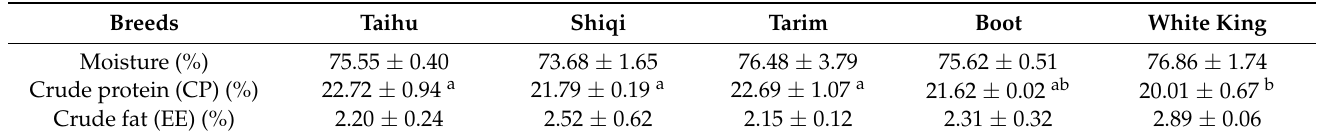
Table 2. Comparison of conventional nutritional compositions between different breeds of pigeons.